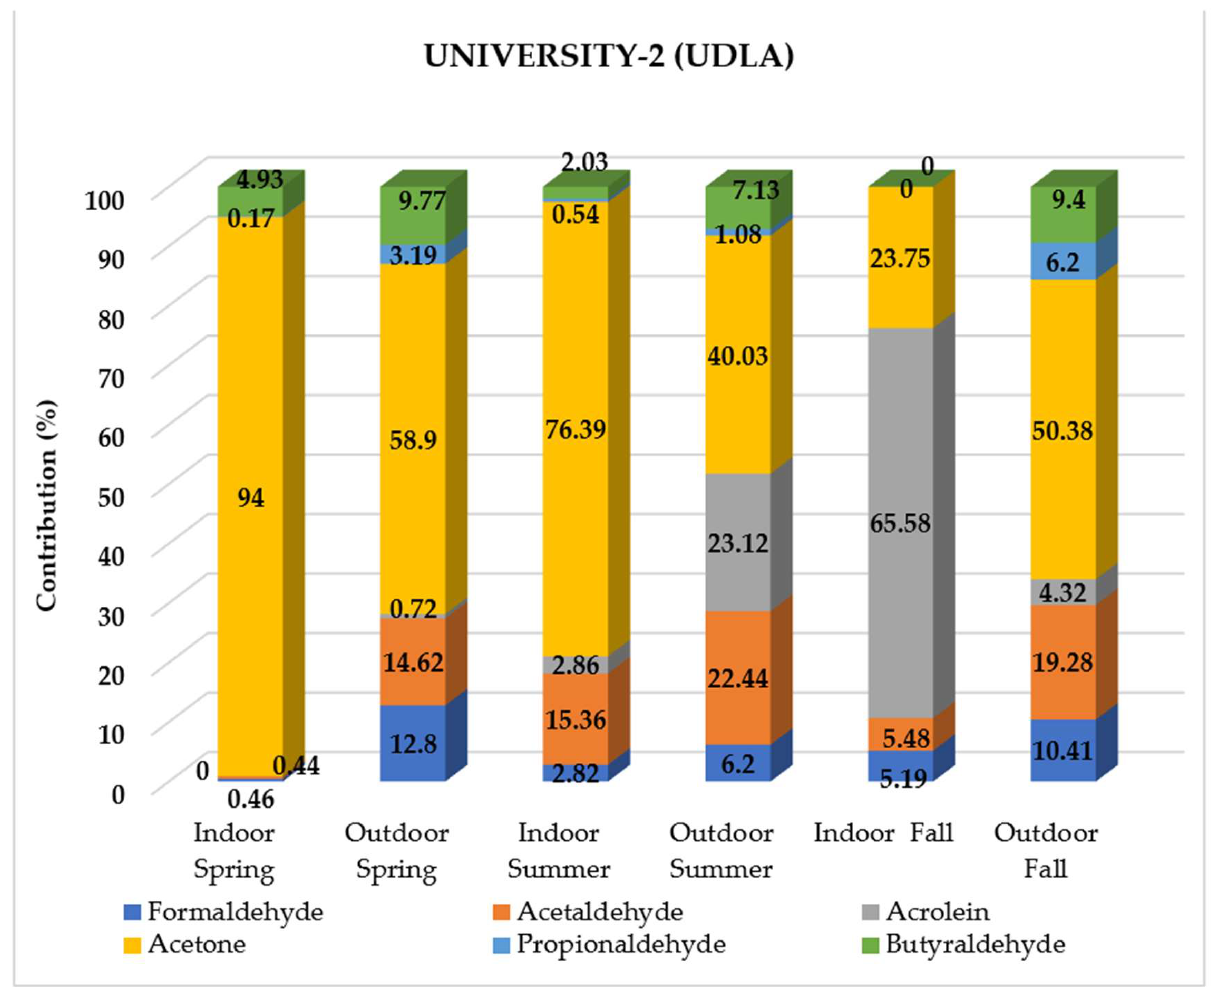
Figure 3. Seasonal variation of the contribution percentage of each carbonyl compound to the total carbonyl concentrations (indoor and outdoor) in University-2 (UDLA).